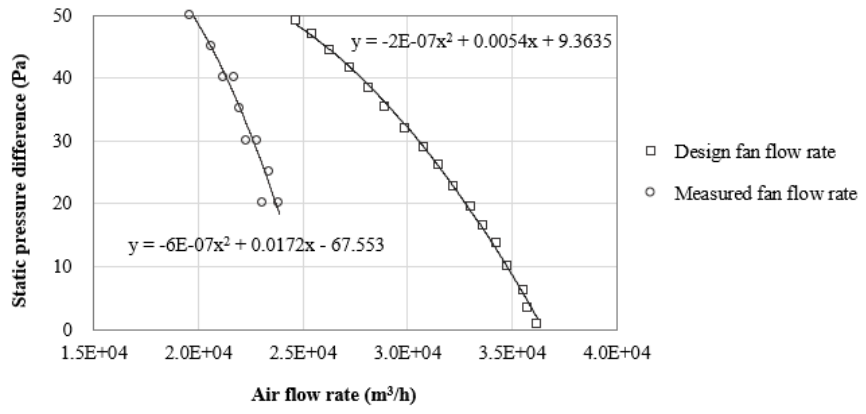
Figure 9. Fan performance curve results in the broiler house. Table 4. Flow rate reduction rate of design fan curve and field fan performance curve according to static pressure difference.